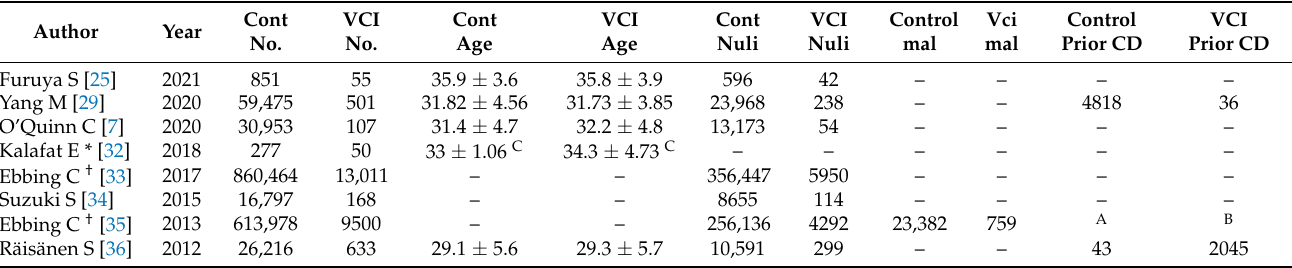
Table 5. Effect of VCI on the rate of adverse obstetric